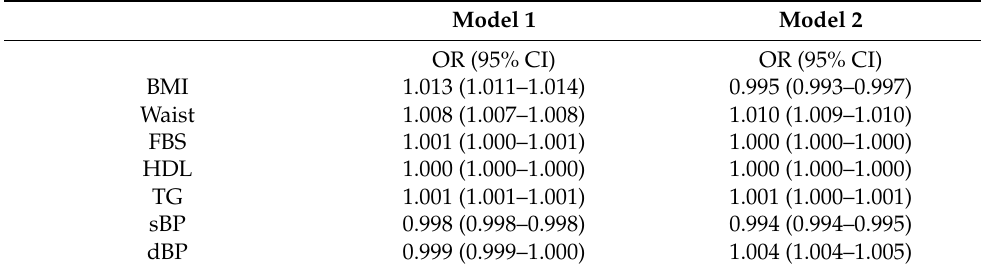
Table 6. Relationship between metabolic syndrome factors and incident depression